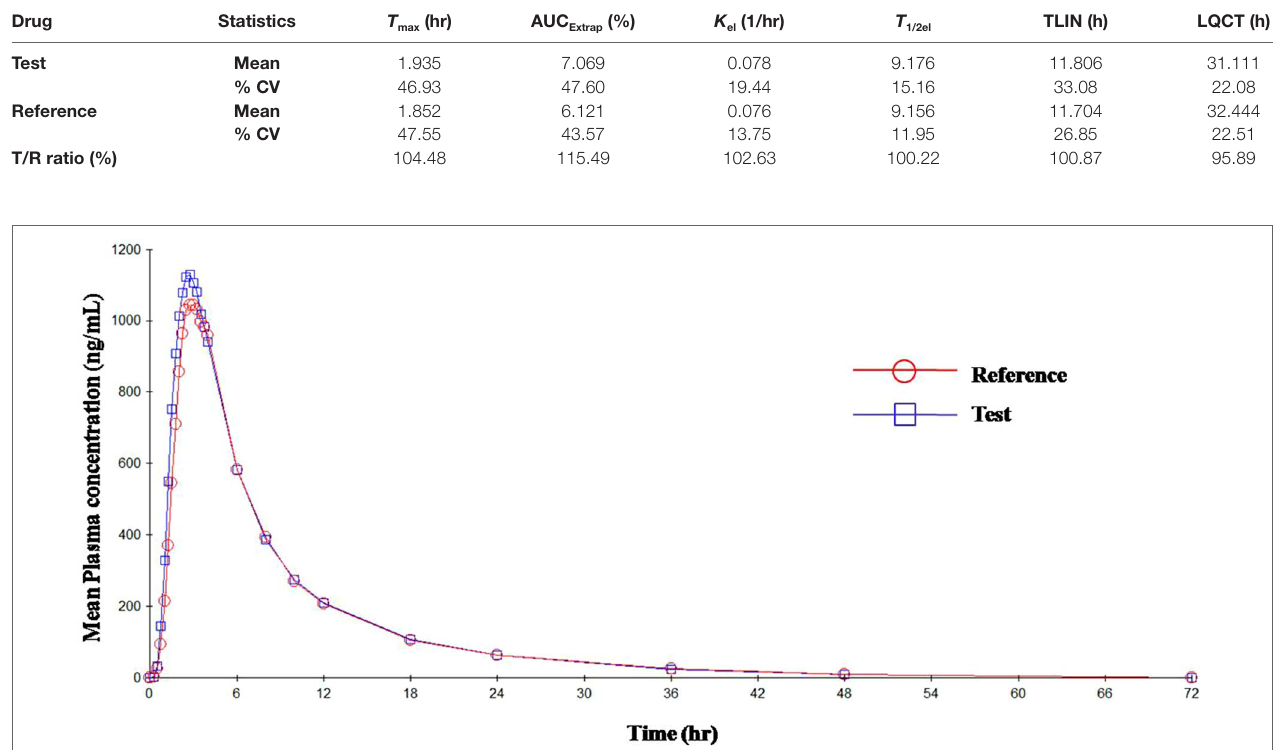
FIGURE 3 | Mean plasma concentration vs. time curve for OLM after administration of single dose of test and reference tablets.